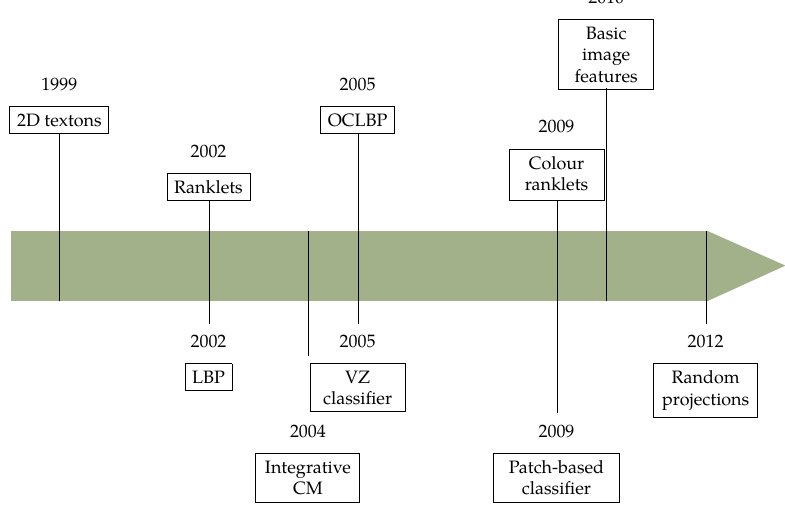
Figure 8. Colour and texture descriptors for visual recognition: chronology of the new